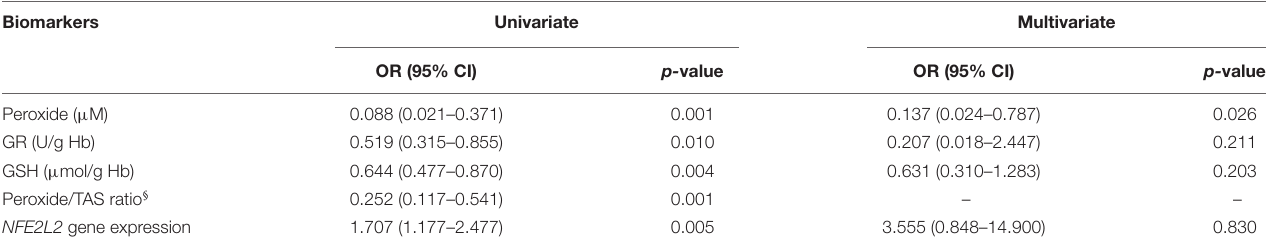
TABLE 4 | Predictive potential of oxidative stress parameters as biomarkers of ESA